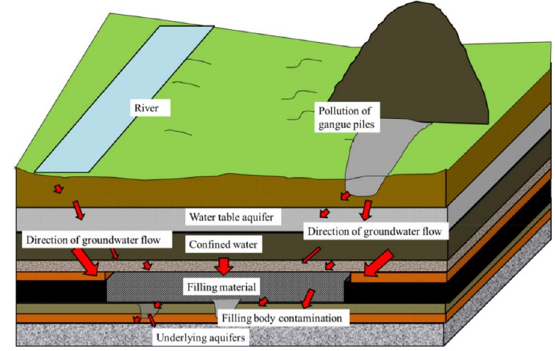
Fig. 1 Diagram of groundwater pollution in a mining